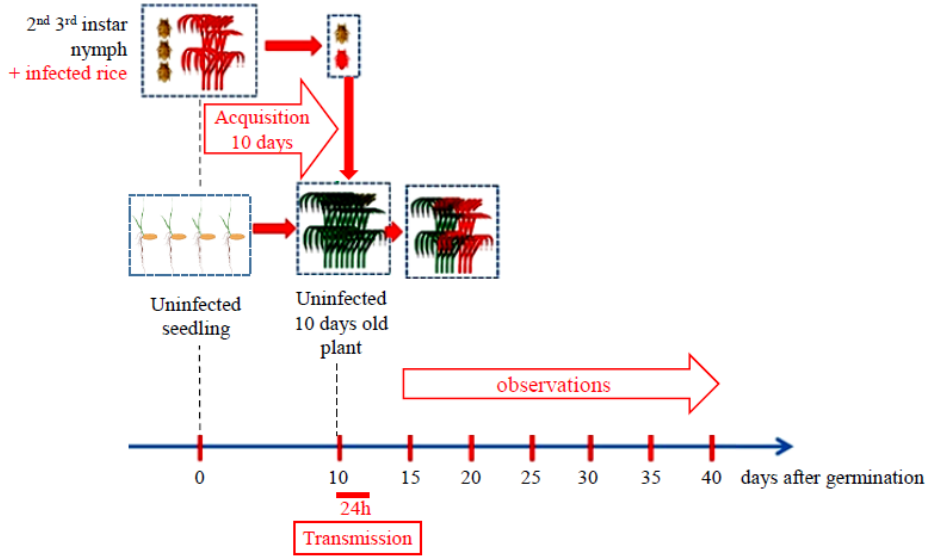
Figure 7. Illustration of the RRSV infection process developed in PPRI for RRSV resistance evaluation. This process consists of three steps, as noted in red. The first step is RRSV acquisition by BHPs over 10 days. The second step is RRSV transmission by viruliferous BHP to 10-day-old plants over 24 h. The last step is plant height observation over 30 days following infection.